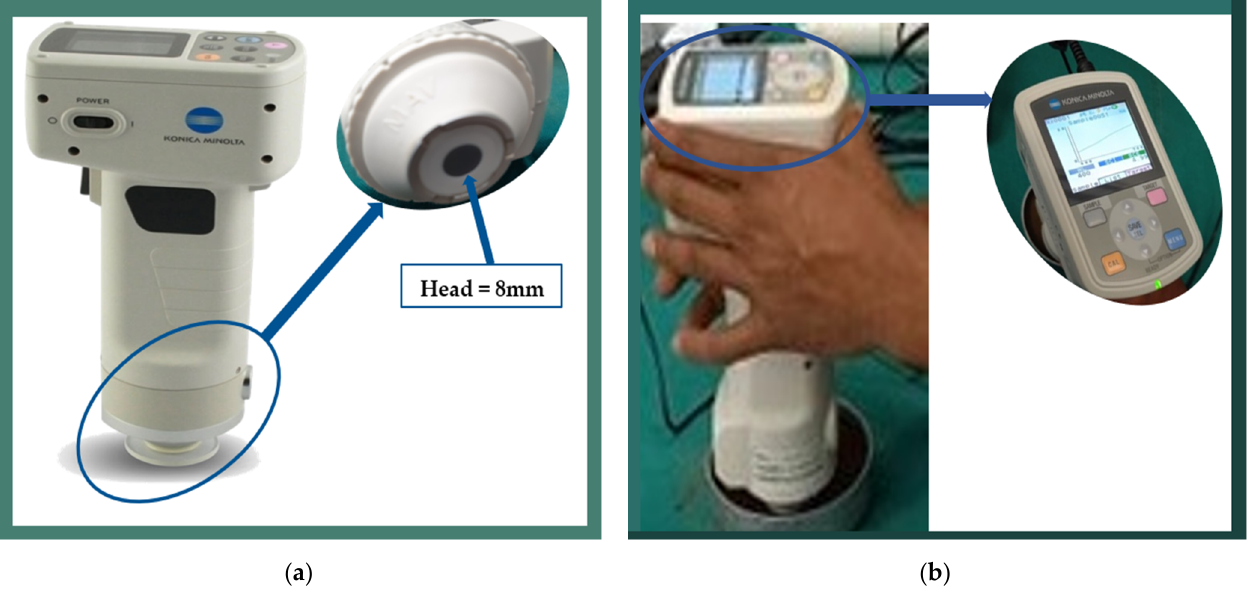
Figure 2. The moisture analyzer (HE53 230 V) showing the ( a ) mass of a sample and ( b ) percentage of moisture content.